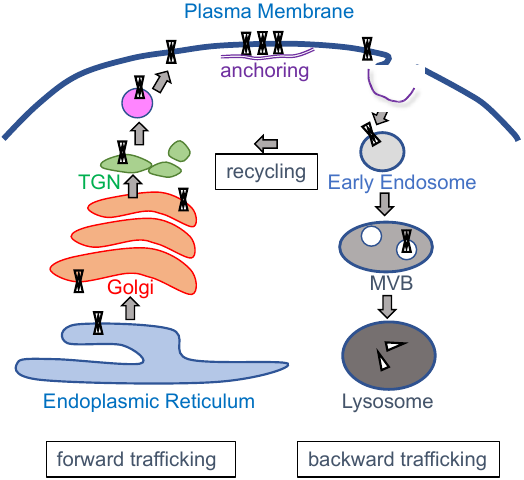
Figure 2. Schematic representation of intracellular trafficking pathways of K IR channels. TGN, trans-Golgi network; MVB, multivesicular body.